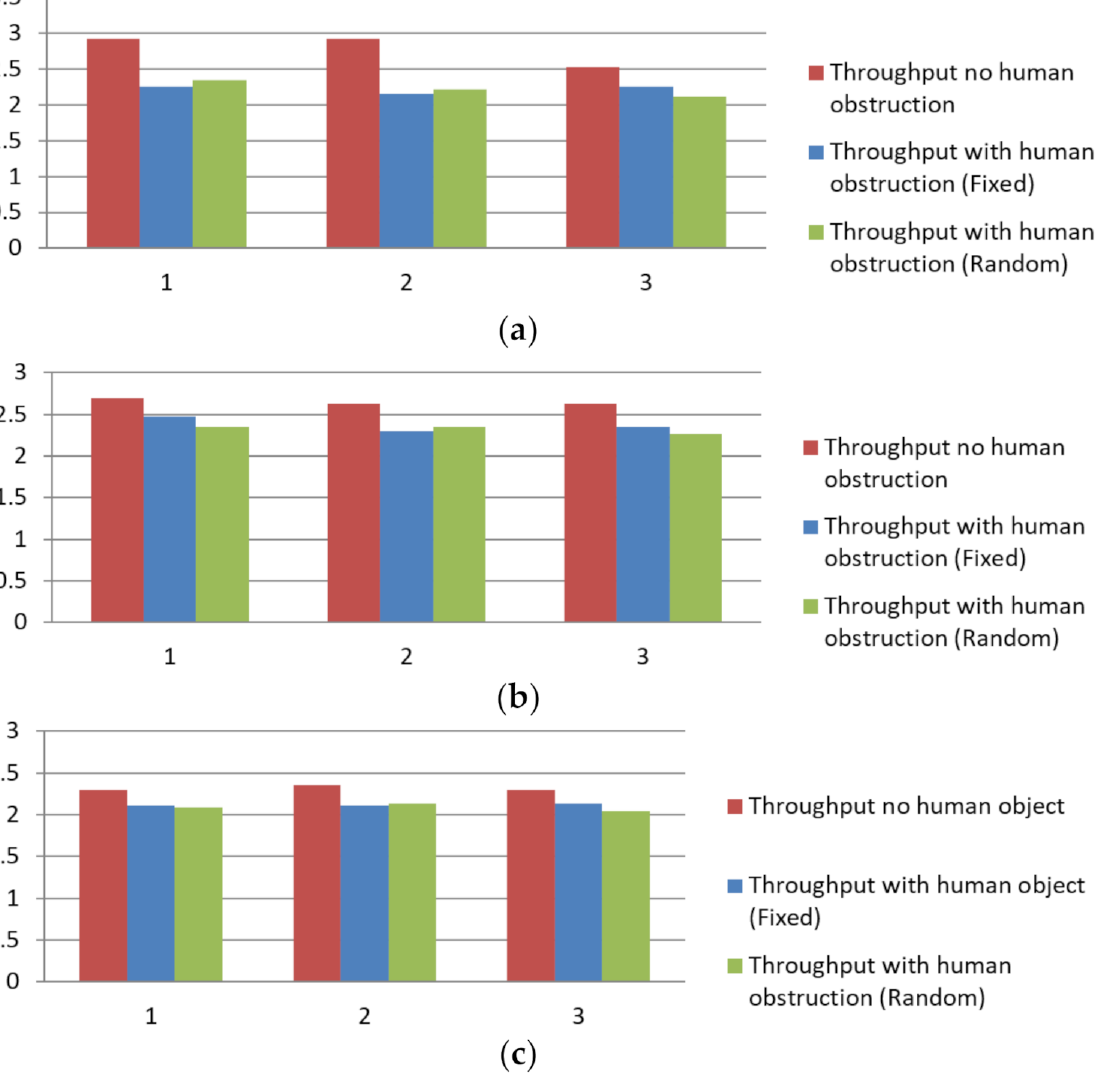
Figure 5. Performance results for suburban residential home. ( a ) Lounge performance result; ( b ) Bedroom performance result; ( c ) Garage performance